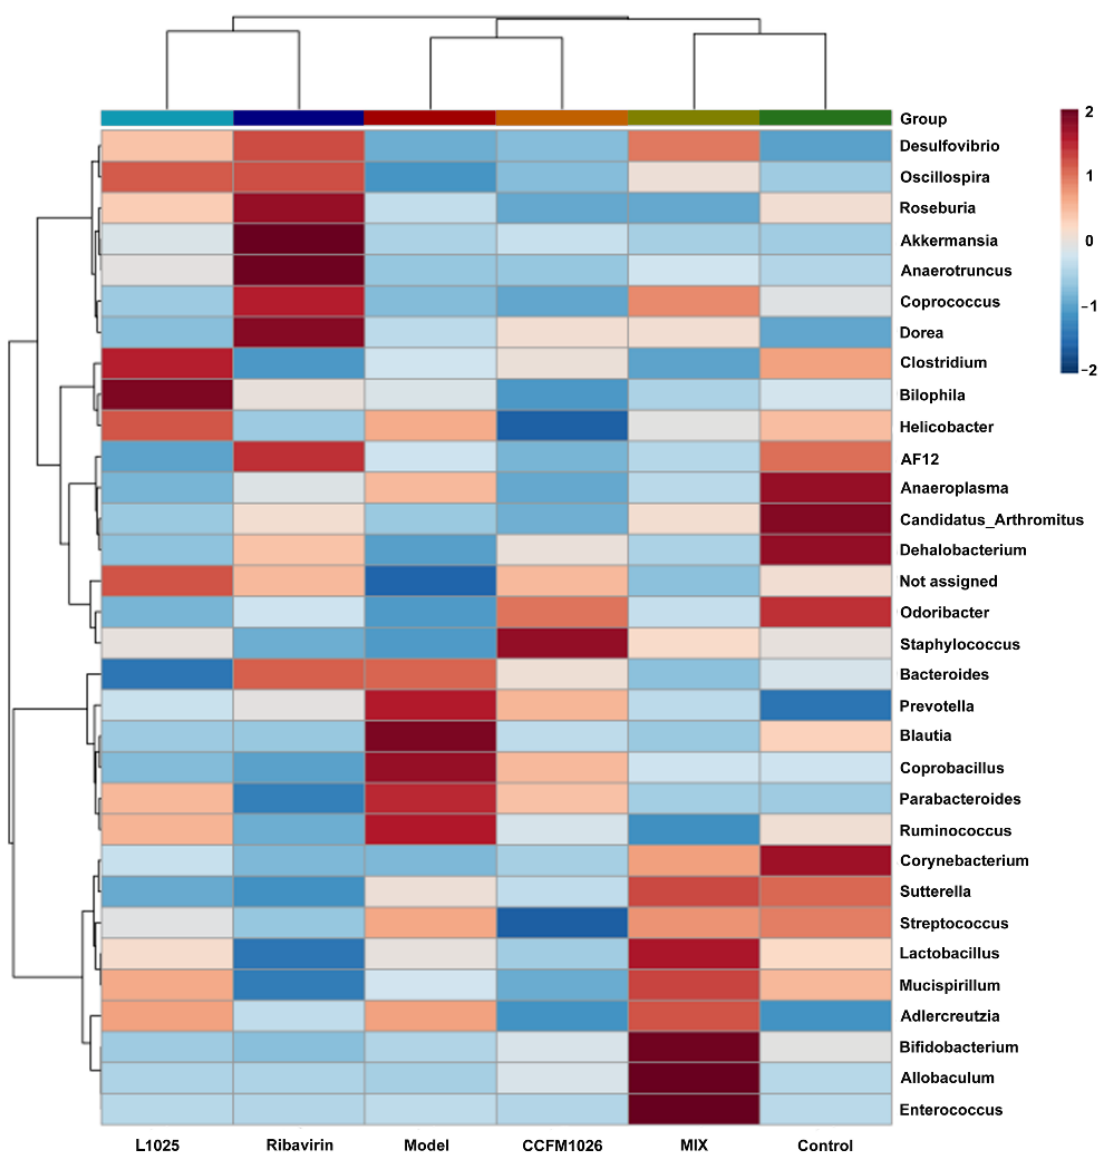
Figure 7. Heatmap related to clustering analysis and alteration in gut microbiota.